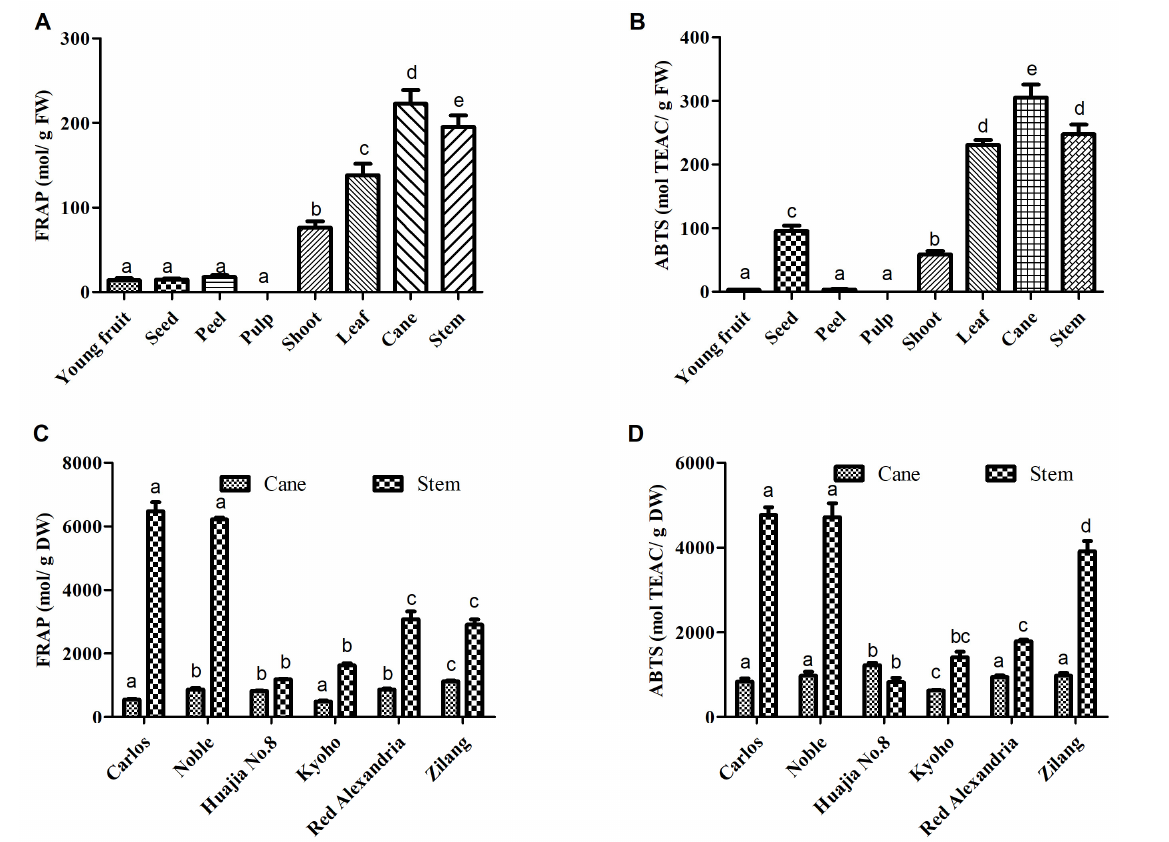
Figure 4. Total antioxidant activities of extracts from different fresh tissues of V. davidii Foex ( A , B ) and from the dried cane and stem extracts of different Vitis L. varieties ( C , D ) determined by FRAP and ABTS. Bars with different letters are significantly different ( p < 0.05).